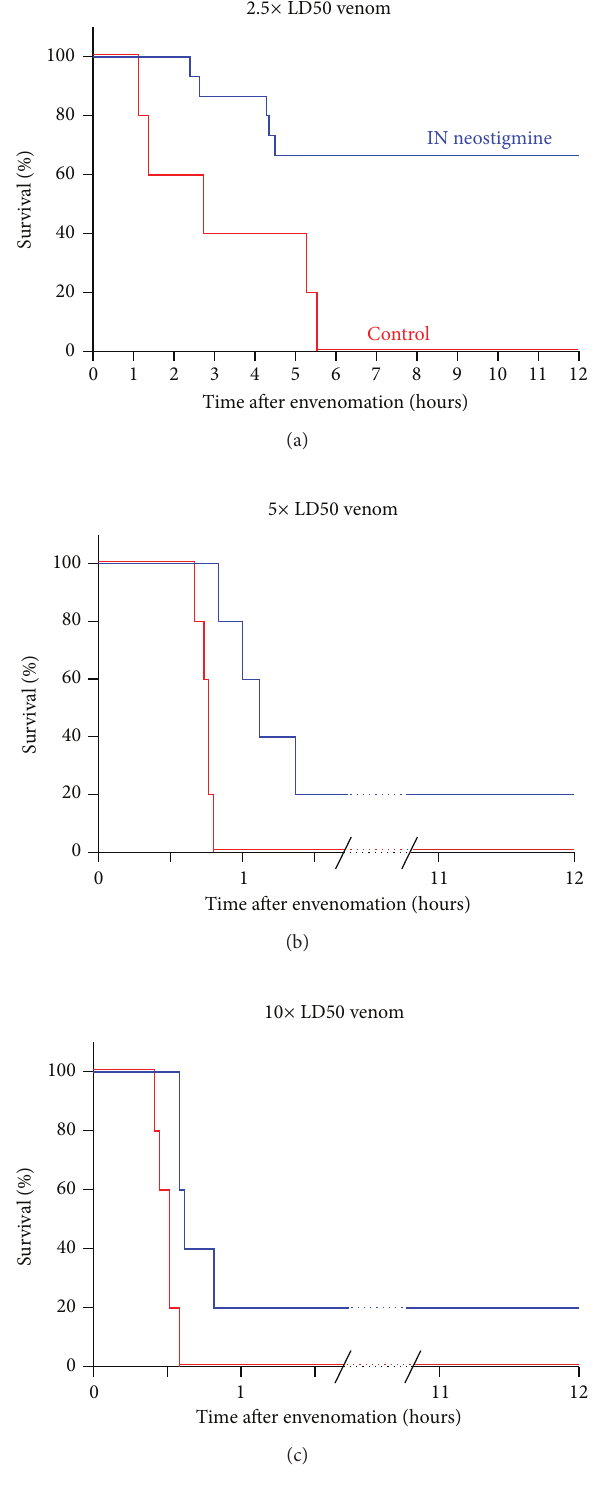
Figure 1: Kaplan-Meier plot of survival times in mice given 2.5 (a), 5 (b), or 10 (c) times the LD50 of N. naja venom and either a single dose of IN neostigmine (treatment groups, blue lines) or IN saline (control groups, red lines). 𝑁 = 5 animals for each group, except 𝑁 = 15 forthe2.5 × LD50treatmentgroup.Therewerenosignificant differences in the mean weight of animals across